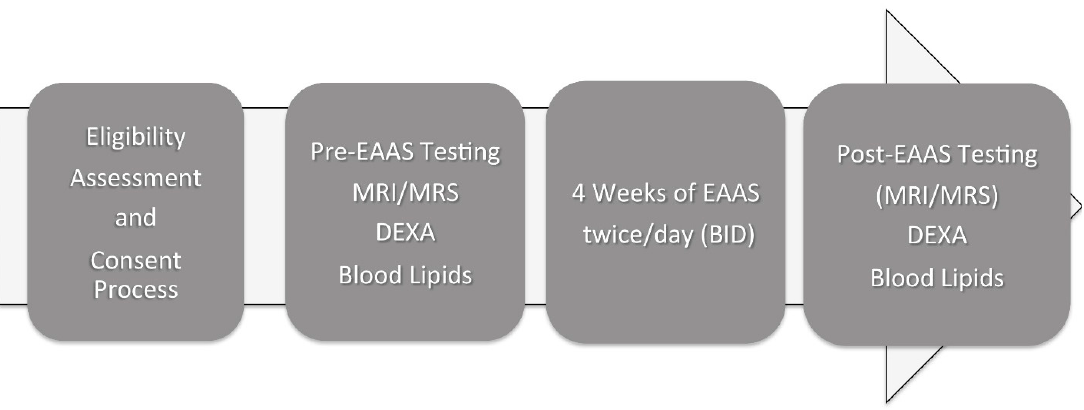
Figure 1. Study Figure 1. Study timeline.